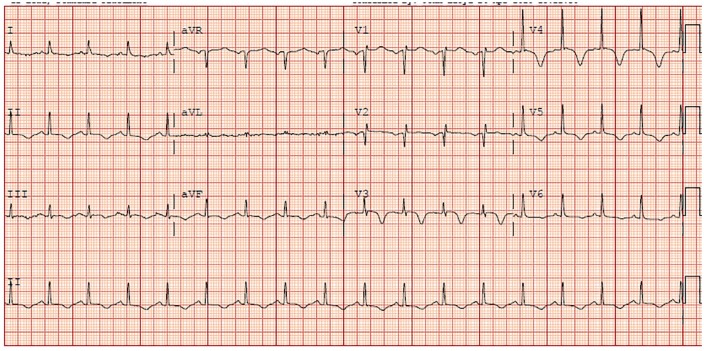
Electrocardiogram with T-wave inversion in V3-V5, II, III, and aVF.